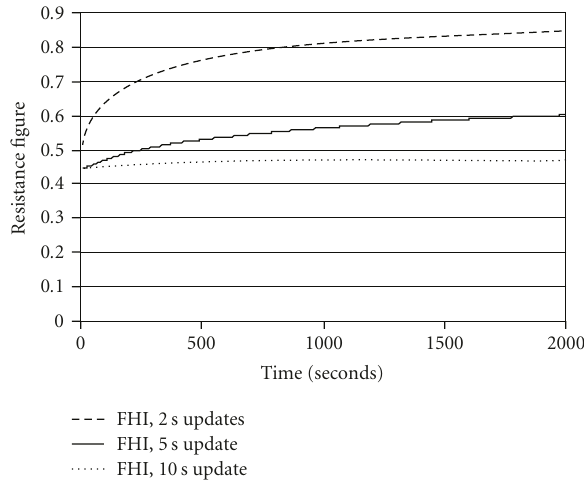
Figure 4: Studying the e ff ect of update periods frequency on the resistance figure considering FHI factor.